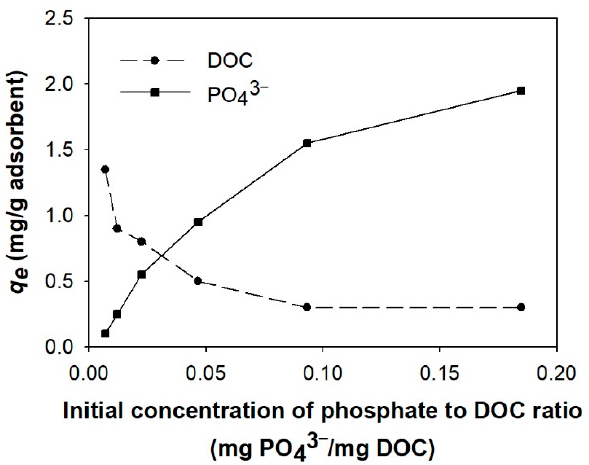
Figure 4. Adsorption capacity of simultaneous DOC and phosphate adsorption at different initial concentration ratios.